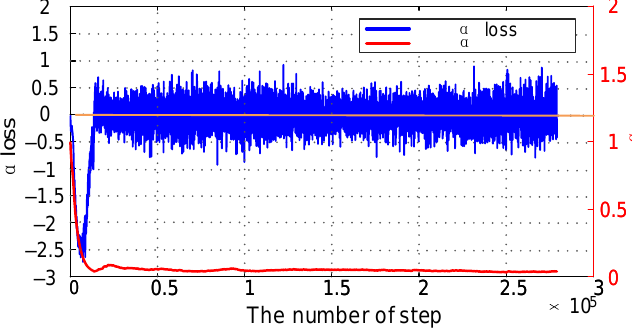
Figure 10. The process of α adjustment. The EM power and SOC trajectory curve of the vehicle are shown in Figure 11. The EM not only acts as a power source but also charges the battery when the EM power is negative. In the SOC maintenance stage, which is the horizontal part of the yellow line, the probability of the negative power is larger to keep the SOC to reference SOC (0.45).